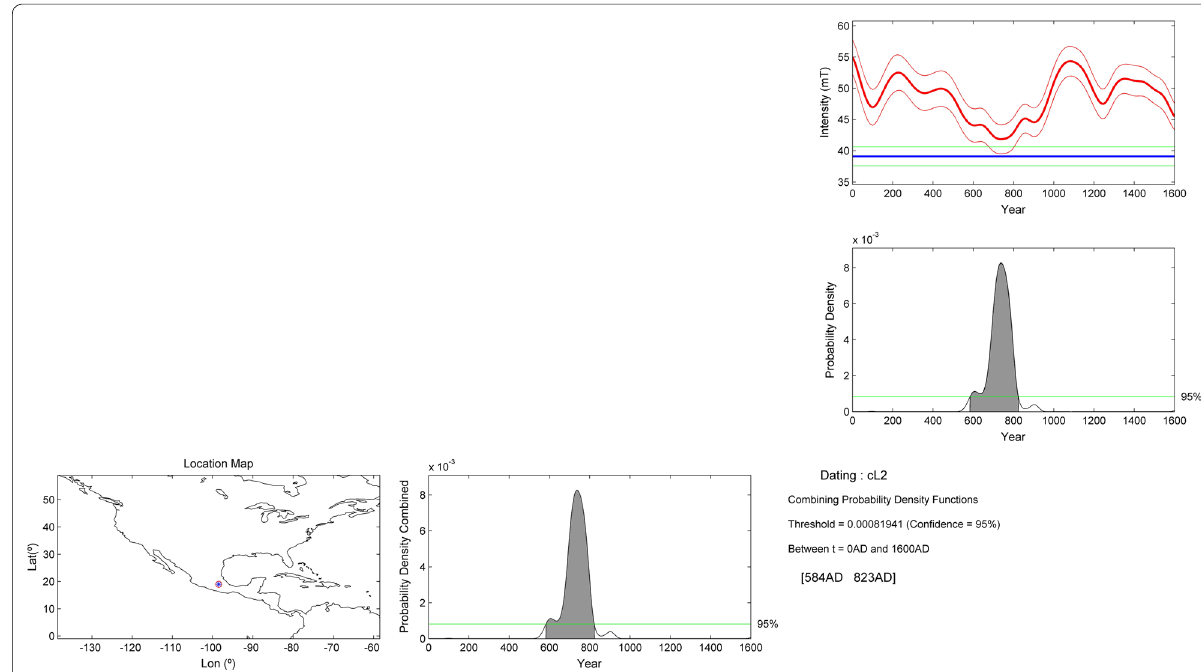
Fig. 18 Paleointensity dating for the pottery shard cL2 based on a mean PI different panels as in Fig.